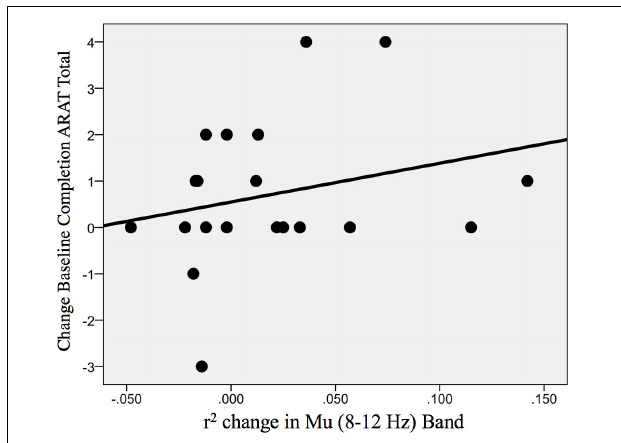
FIGURE 10 | Association between the change in r-squared values (Mu rhythm, 8–12 Hz) as the result of BCI training with the change in ARAT scores (obtained post-intervention in comparison to baseline) [ ρ (20) = 0.30; p = 0.098].